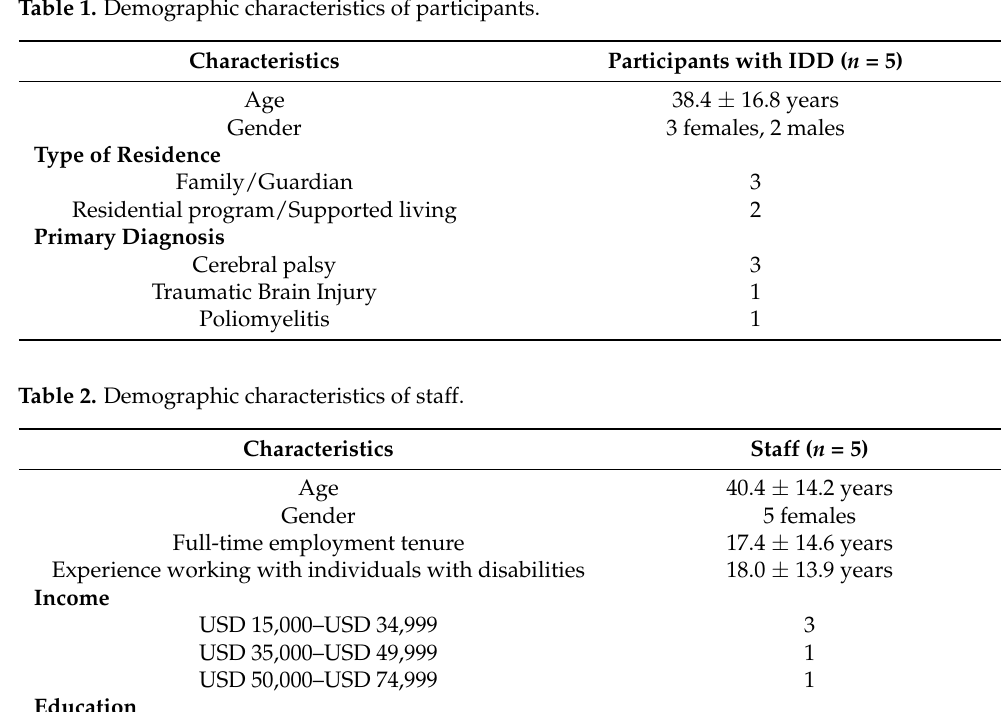
Table 1. Demographic characteristics of participants.